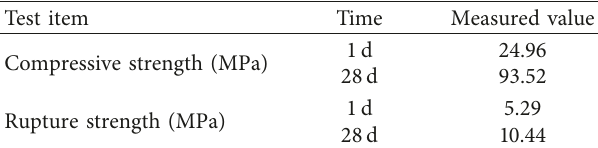
Table 3: Mechanical property of high-performance mortar.